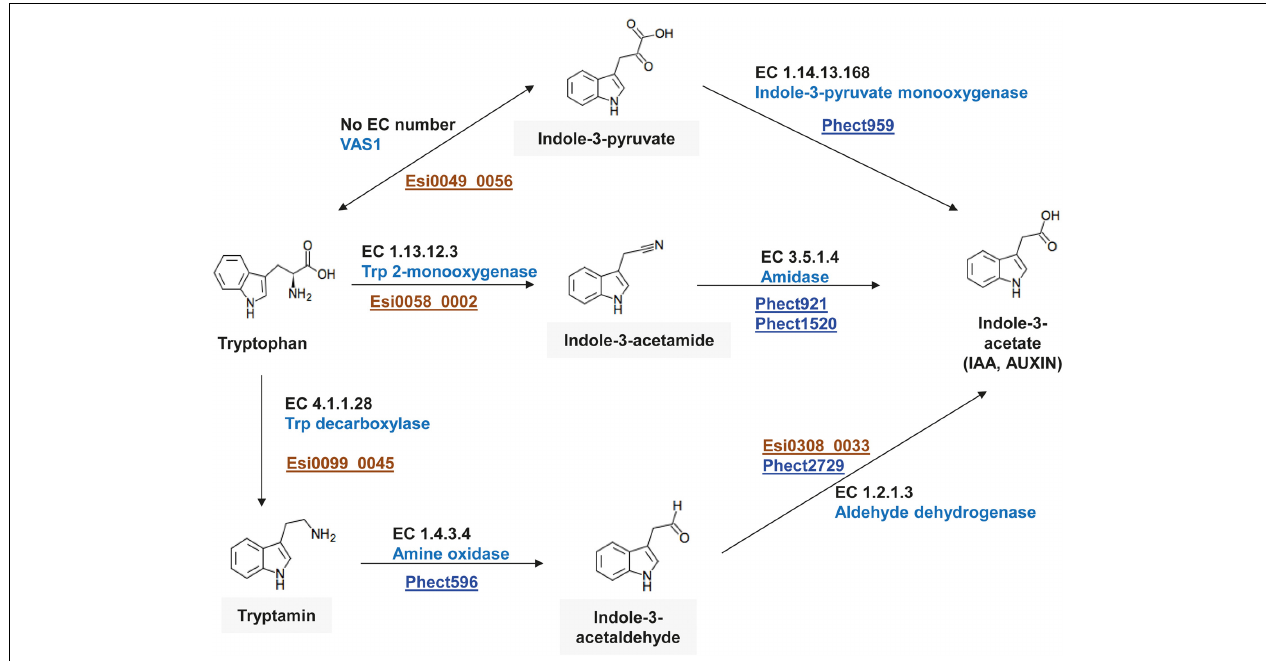
FIGURE 4 | Genes involved in tryptophan-dependent auxin synthesis in “ Ca. Phaeomarinobacter ectocarpi” Ec32 (blue loci) and E. siliculosus (brown